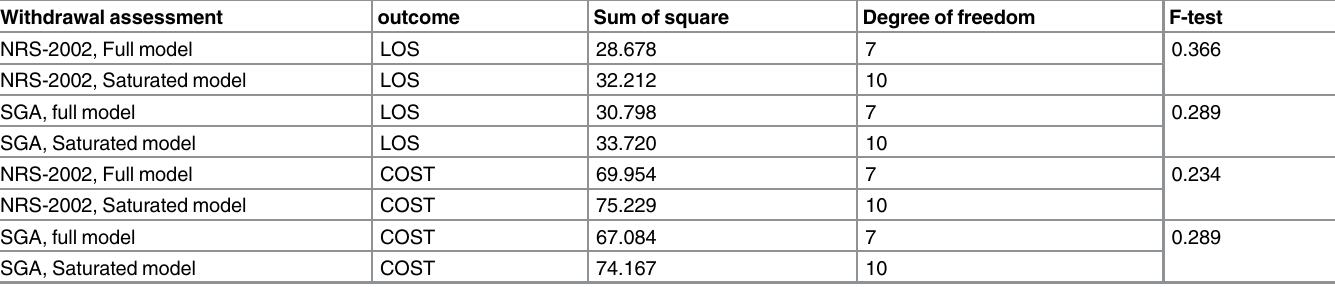
Table 4. Model comparison and f-test.